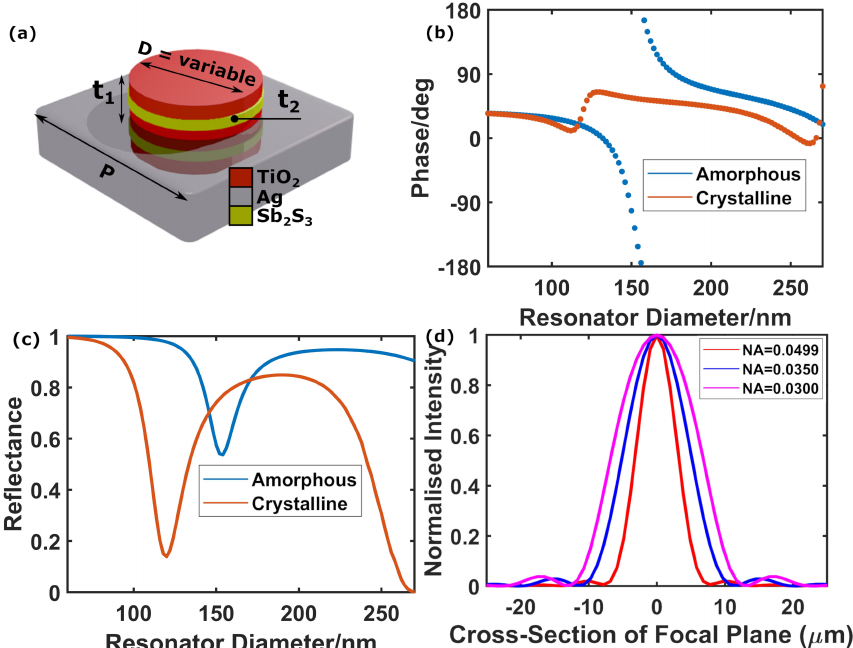
Figure 5. ( a ) Meta-atom design for 632.8 nm wavelength operation, with a Sb 2 S 3 layer centred between two TiO 2 layers on a silver back-plate. Geometrical parameters are here p = 370 nm, t 1 = 74 nm and t 2 = 32 nm. ( b , c ) Optical phase ( b ) and amplitude ( c ) variation as a function of the resonator diameter D for amorphous (blue) and crystalline (red) states. ( d ) Intensity profiles of focal spots generated by the 632.8 nm wavelength design with focal length 10 cm. The profiles shown are for the entire device in the crystalline phase (NA = 0.0499, red), and for amorphous inner regions of radii of 0.35 cm (NA = 0.0350, blue) and 0.30 cm (NA = 0.0300, magenta). The profiles are all normalised to the same scale to allow easier comparison of the